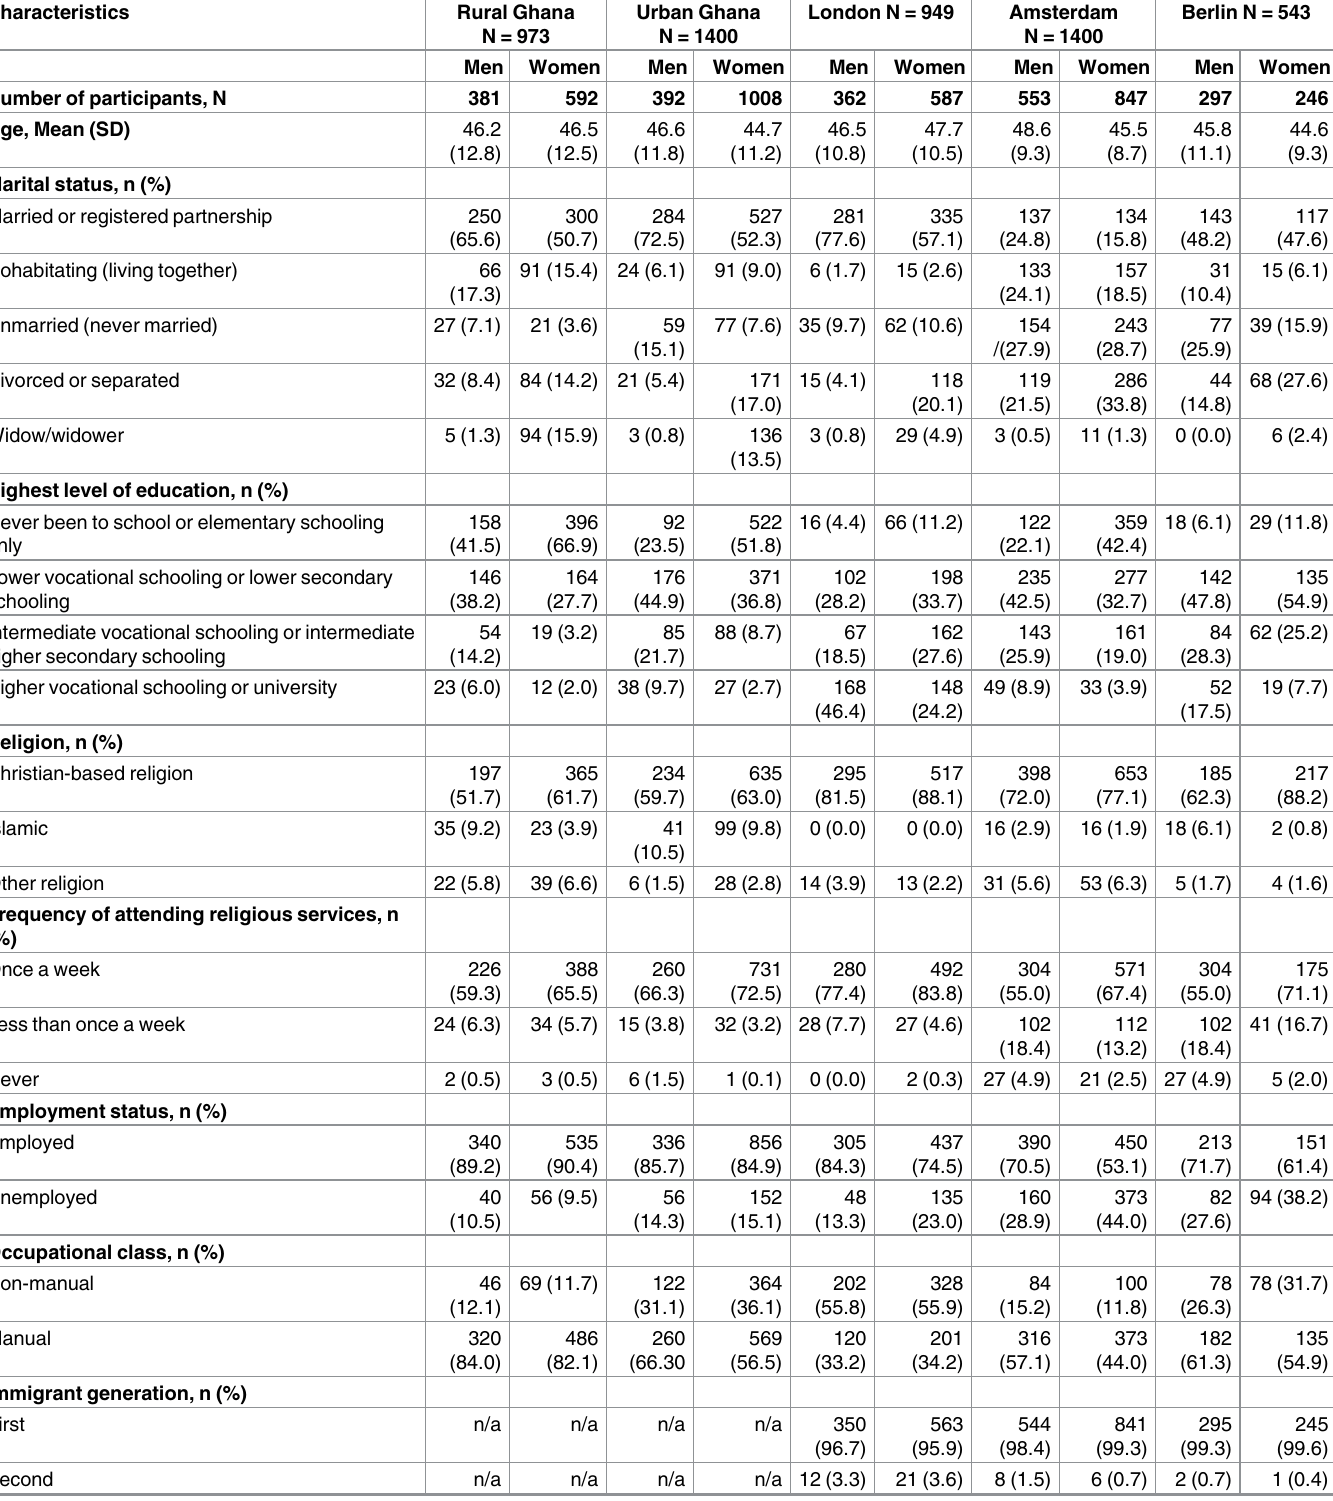
Table 1. Socio-cultural and migration-related characteristics of male and female Ghanaians in each study location.